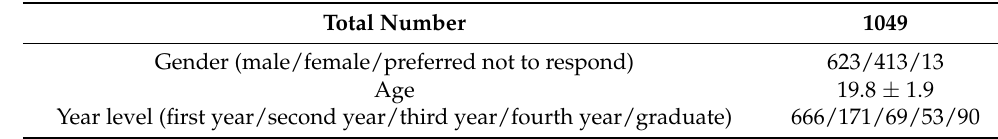
Table 2. Demographic data of the participants.